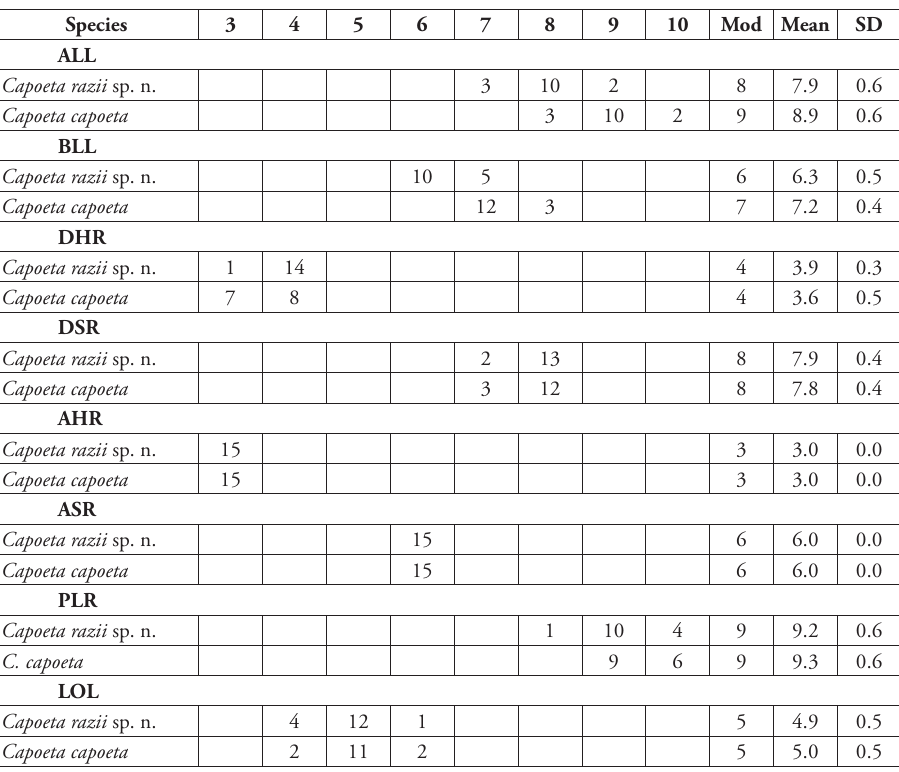
Table 6. Number of pectoral (PFR), caudal fin rays (DFR), total gill rakers (TGR) and circum-pendicu- lar scales (CPS) in Capoeta razii sp. n. and C. capoeta . Species 15 PFR Capoeta razii sp. n. Capoeta capoeta CFR Capoeta razii sp. n. Capoeta capoeta CPS Capoeta razii sp. n. Capoeta capoeta TGR Capoeta razii sp. n. Capoeta